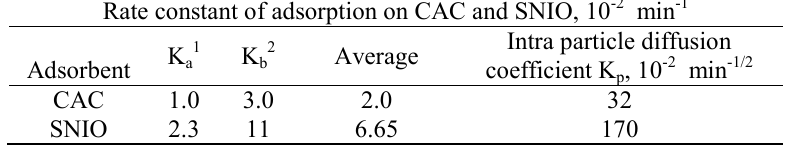
Table 1. Rate constant of the adsorption of the Ni(II) ion by CAC and SNIO at different time interval.